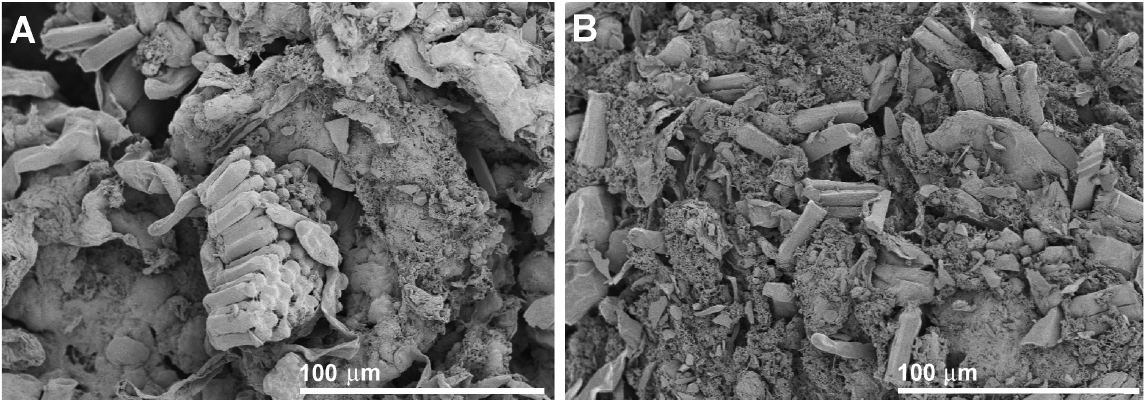
Figure 4 . Treatment of alfalfa sprout samples with cheesecloth fi ltration and low-speed centrifugation does not impact physical com- plexity at the microscopic level. These lower-magni fi cation SEM photos of an untreated sample (Panel A) or a sample treated with cheesecloth and centrifugation (Panel B) shows that both samples have a similar physical complexity at the microscopic level, and con- tain relatively large pieces of plant debris (stem or root material) and palisade parenchyma cells, all coated with a fi ne, fuzzy network of native sprout